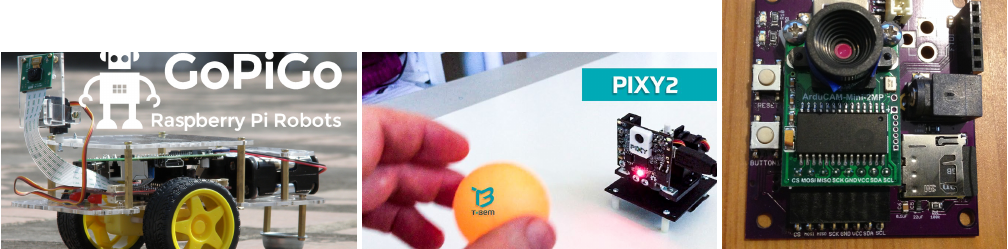
Figure 2. GoPiGo Raspberry Pi-based robot, PixyCam and ArduCam Arduino-based